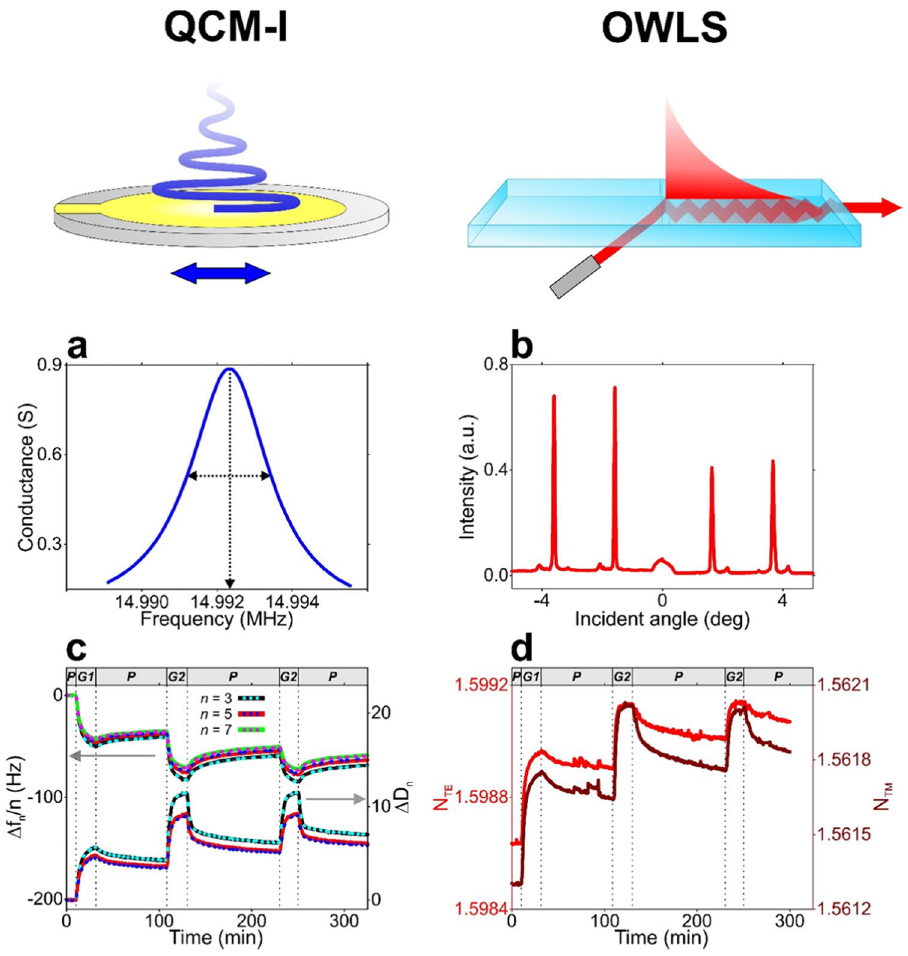
Figure 2. Measurement principle of the QCM-I and OWLS biosensor techniques and obtained raw data from in situ measurements on gelatin layer formation. ( a , b ) Raw data obtained from QCM-I and OWLS the measurements: the resonance peak around the 3 rd overtone resonance frequency ( a QCM-I) as well as the intensity peaks of the excited modes at the coupling angles ( b OWLS). In the case of QCM-I, the frequency and full width at half maximum (FWHM) value of the resonance peak are registered at each measurement time and the resulting normalized frequency shift ( Δ f n / n ) and dissipation shift ( Δ D n ) data (the latter calculated from FWHM) at the selected n overtones are used for the model fit. ( c ) Gelatin deposition experiment monitored by in situ QCM-I. The measured Δ f n / n and Δ D n data are represented by solid lines with different colors, while the data resulting from fitting the Voigt-based viscoelastic model are represented by colored dashed lines. The graph header and dashed vertical lines indicate the phases of the deposition experiment (P: PBS flow, G1: flow of 0.2 mg/ml gelatin solution, G2: flow of 2 mg/ml gelatin solution). ( d ) Effective refractive index data corresponding to the transverse electric ( N TE , red line) and magnetic modes ( N TM , brown line) obtained by parallel OWLS measurement on gelatin layer formation (the experiment was performed with the same phases detailed above for